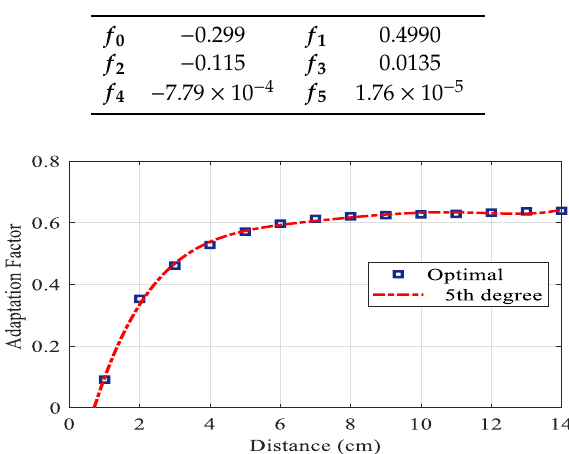
Table 6. Coe ffi cients of Equation (24).